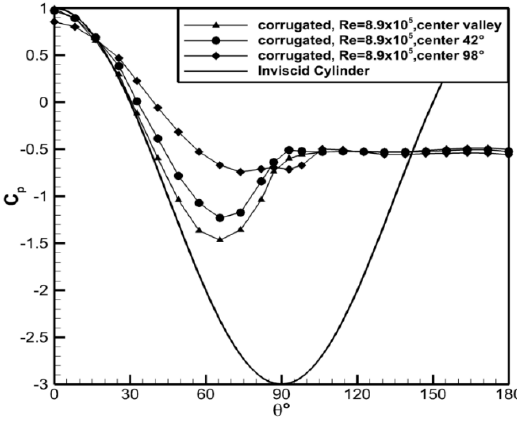
Figure 12. Pressure distribution as a function of channel wall location.